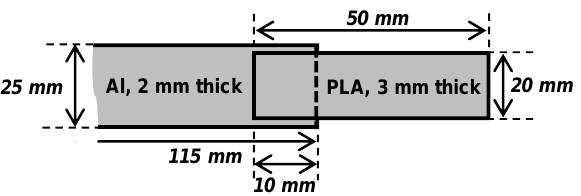
Figure 3. The tensile tests were driven displacement controlled with 2 mm/min cross-head speed. The Table 1. Overview of selected thermal and mechanical properties of the materials used. The surface tensile single-lap-shear strength, 𝜏 𝑆𝐿𝐽 = 𝐹 𝐵 𝐴 𝐽 ⁄ , was calculated based on the breaking load, F B , and the roughness of the aluminum substrates is measured with a Mahr MarTalk profilometer. Values joint area, A J . Tensile tests were carried out within 5 hours after sample production to reduce aging marked with a “*” correspond to a different type of PLA. effects.